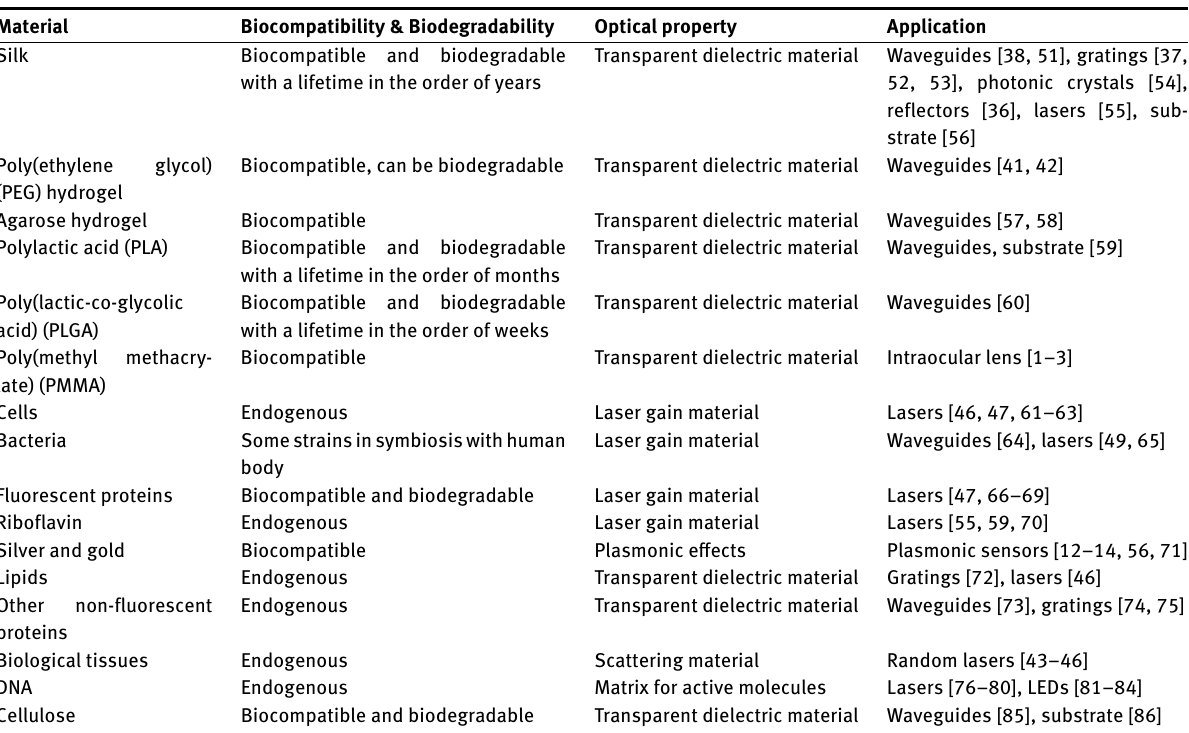
Table 1. List of selected biomaterials that have been used in implementable photonic devices.